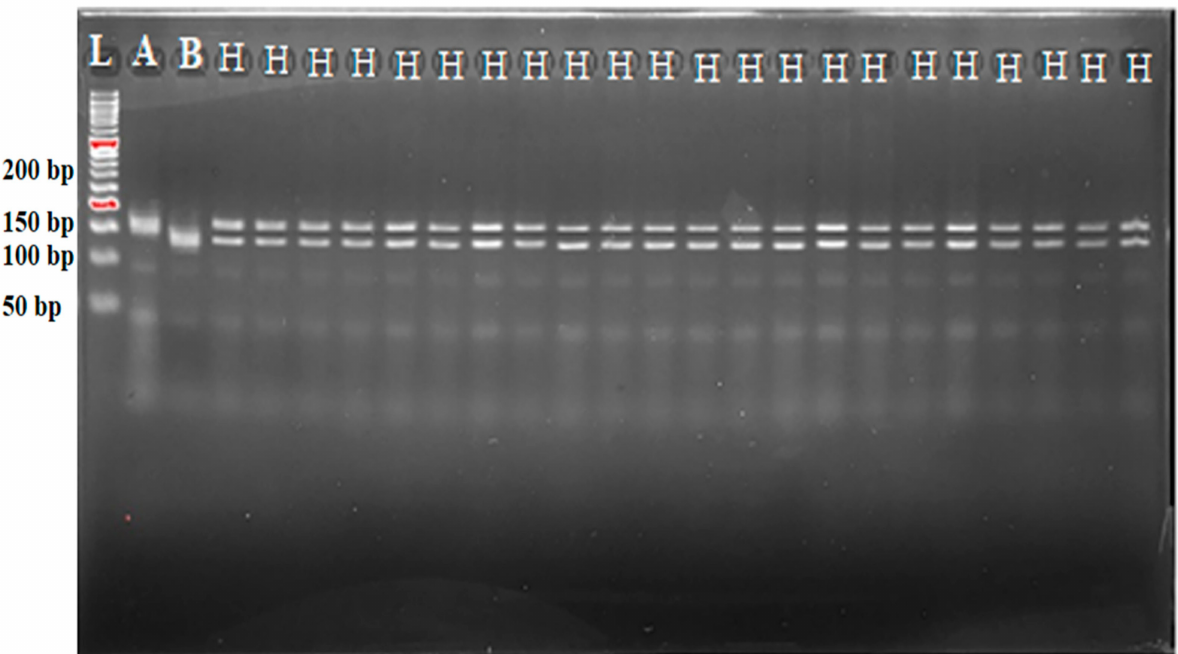
Figure 4. Genotyping and foreground marker-assisted selection of BC 1 F 1 progenies using RM21 tightly linked marker for ( xa5) Xoo resistance gene. A: MR297; B: IRBB60. H represents heterozygotes; L: 50 bp DNA